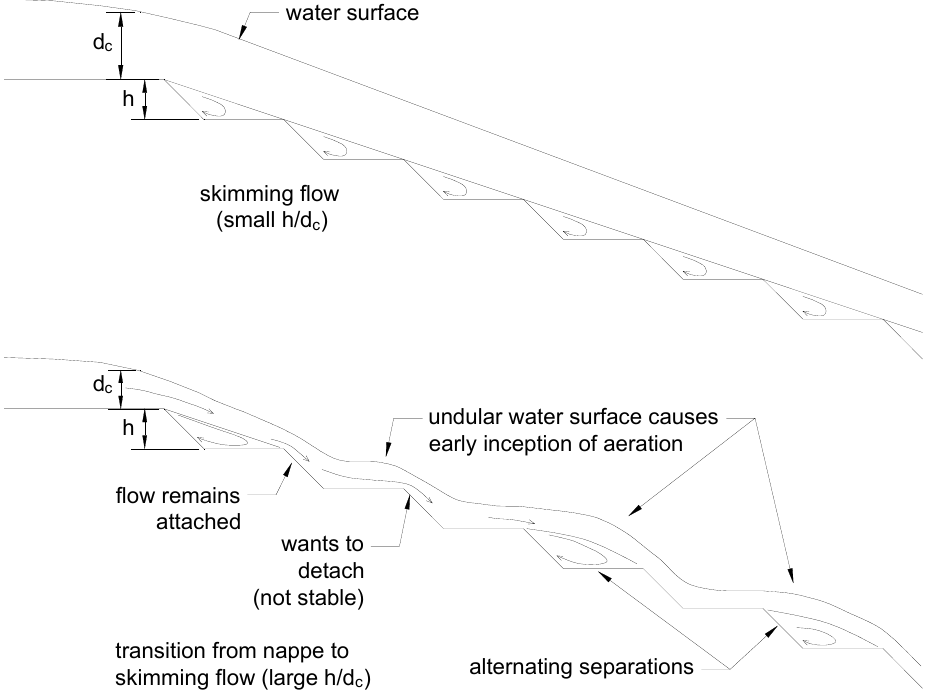
Figure 6. Flow pattern possibilities for beveled face stepped chutes.